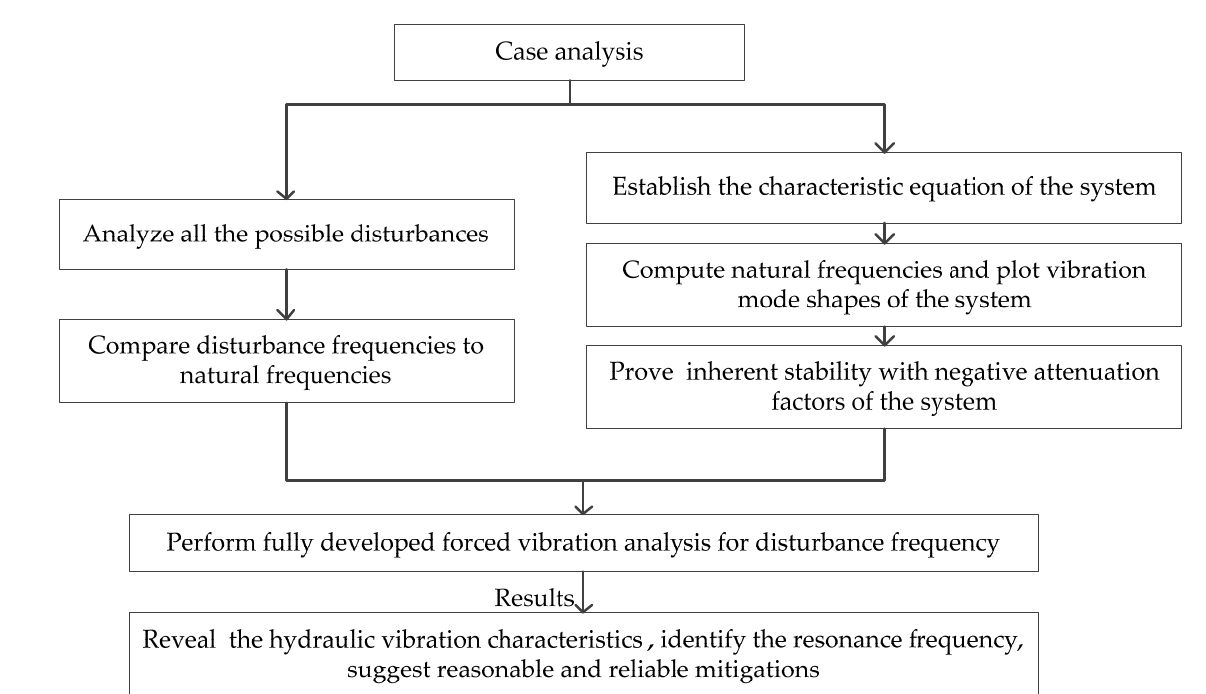
Figure 6. Hydraulic vibration analysis method.